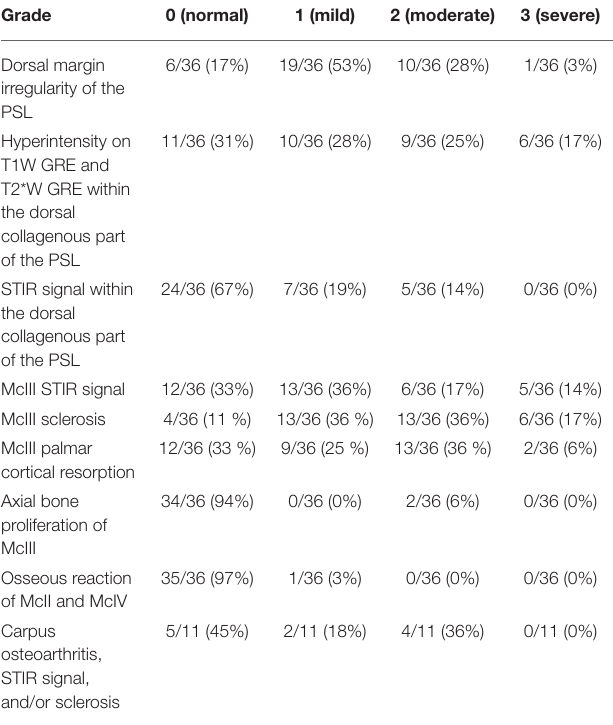
TABLE 1 | Grading of pathological findings per limb in lame group identified using MRI.